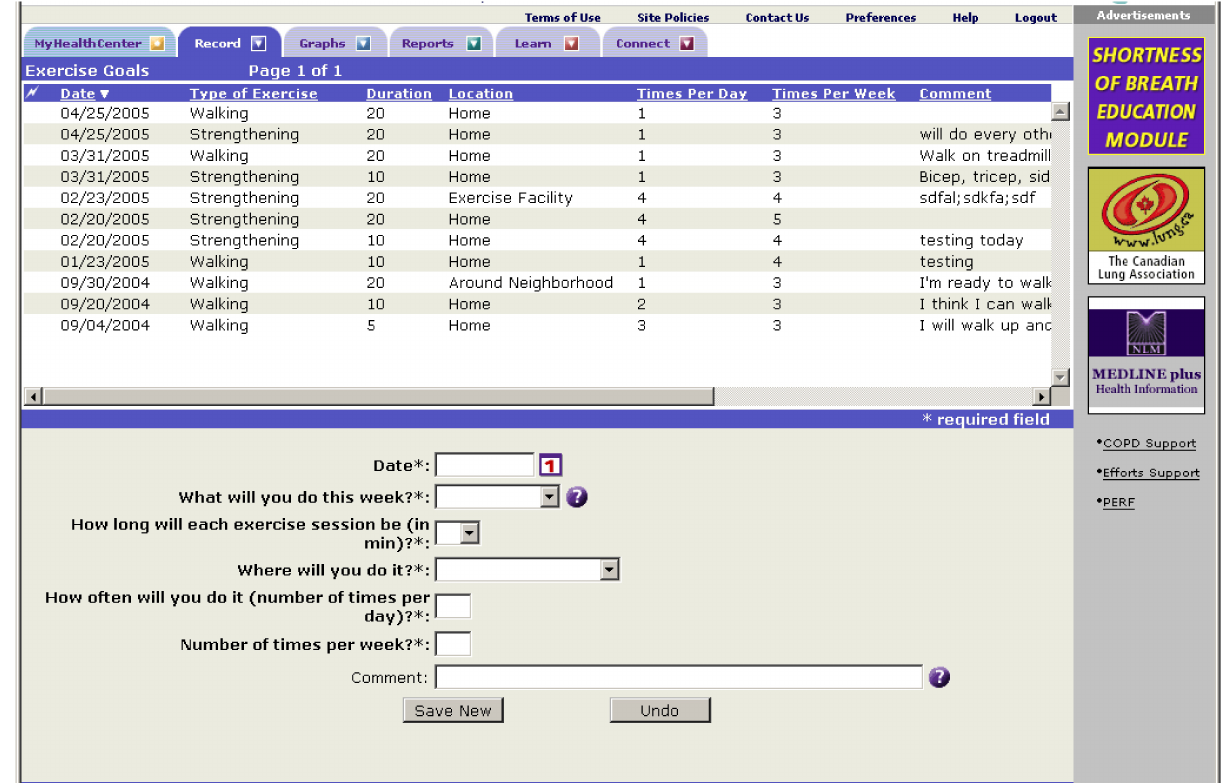
Figure 2. Exercise goal setting (eDSMP